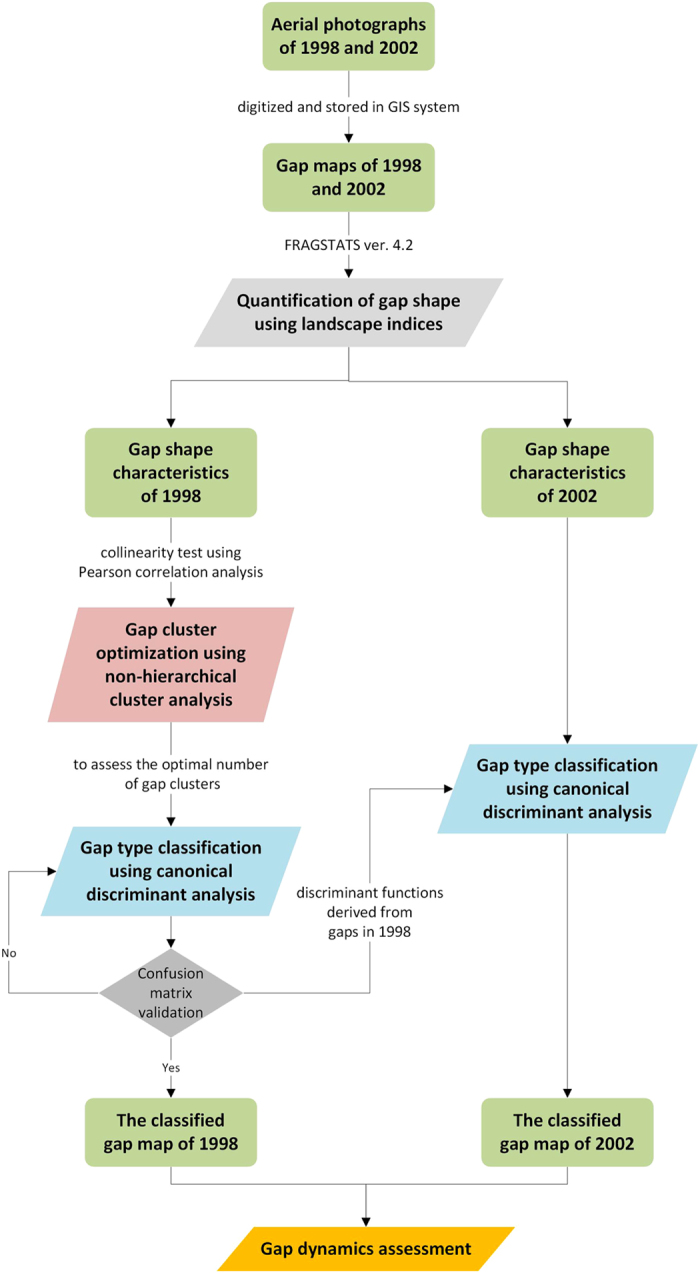
Study framework.